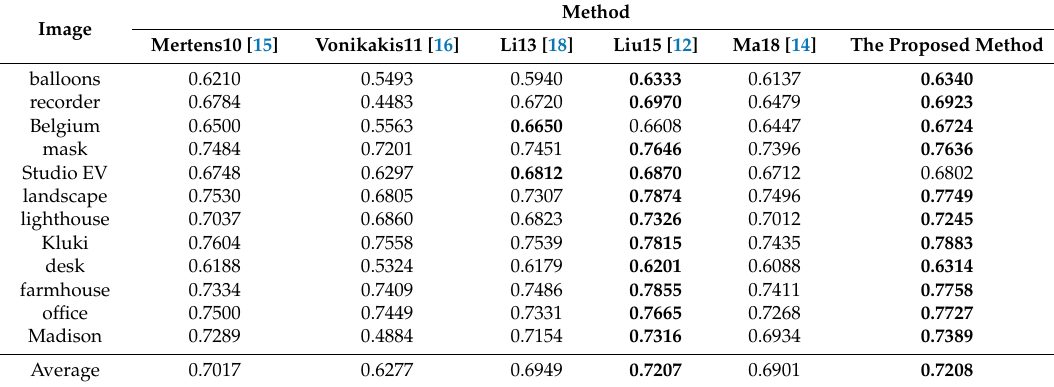
Table 1. Performance of different methods on the 12 image sequences, using Q AB / F [37]. Top two values are shown in